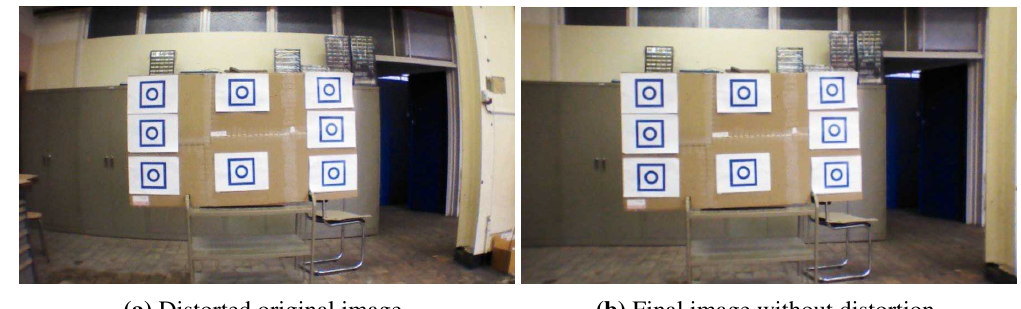
Figure 4. AR.Drone 2.0 pictures from the frontal camera: ( a ) original image with radial distortion; ( b ) image obtained after the remap process with the calculated distortion